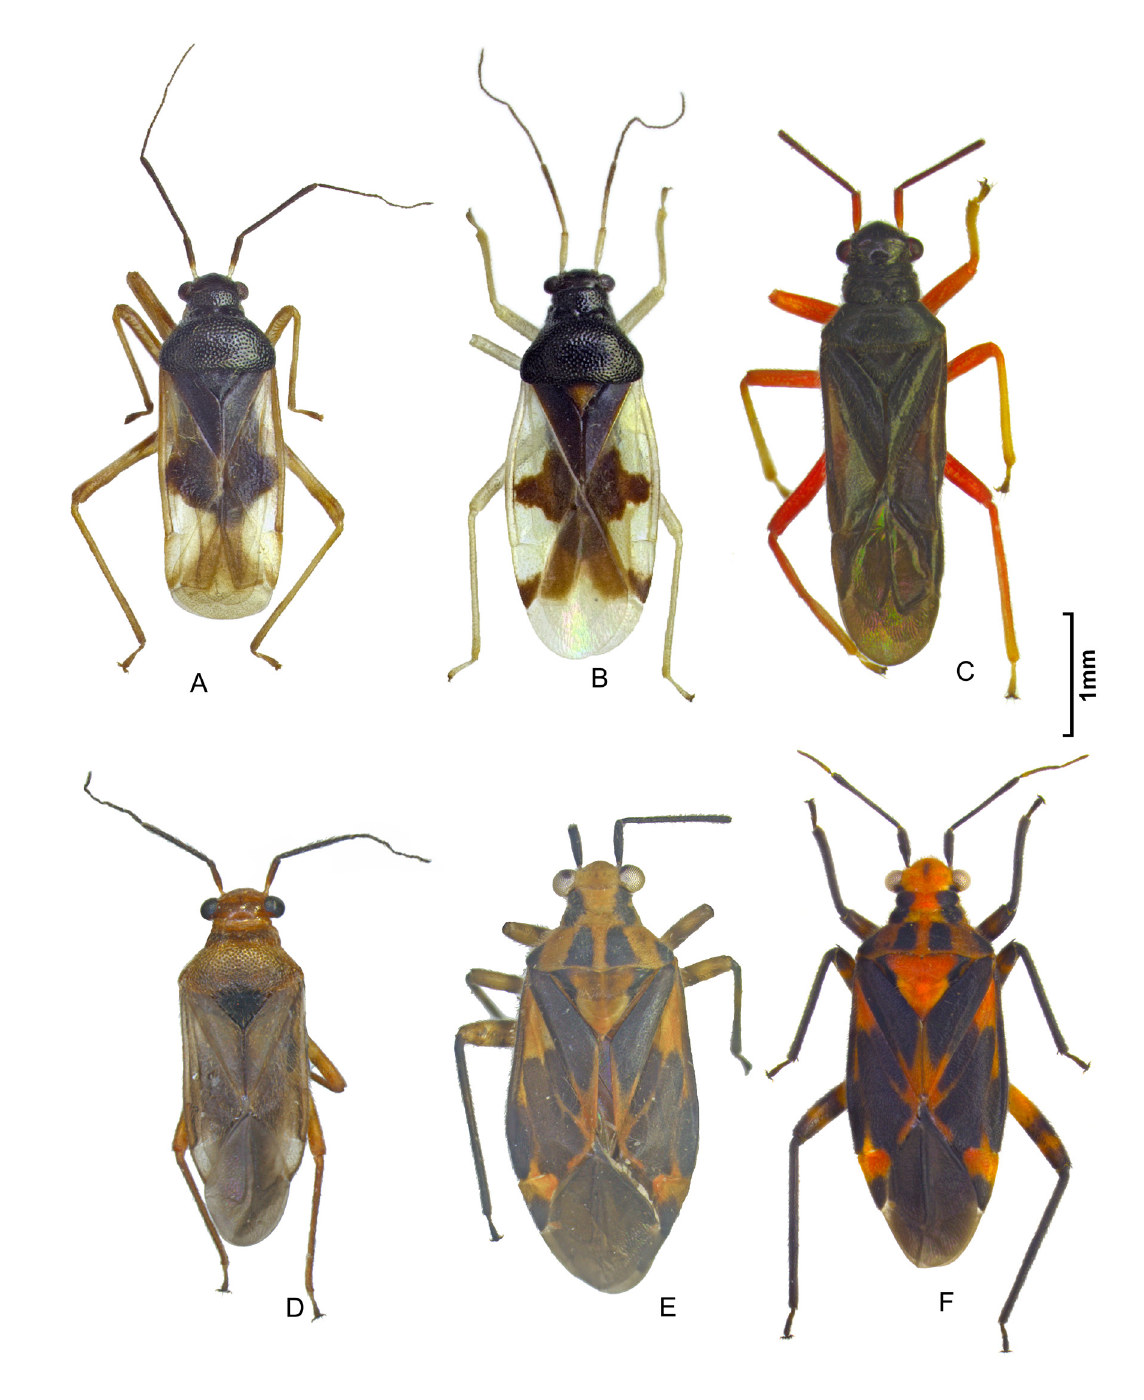
Fig. 2. Habitus of Ernestinus , Harpedona and Lopidolon spp. A . Ernestinus mimicus Distant, 1911,